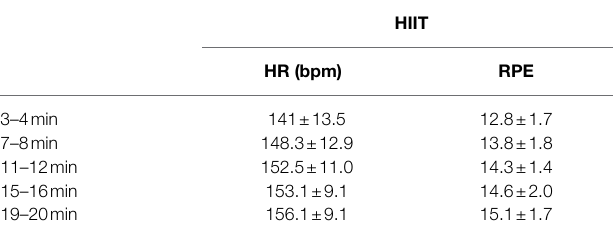
TABLE 1 | Heart rate (HR) and rating of perceived exertion (RPE) during work periods of the high-intensity interval training (HIIT) cycling bout; bpm, beats per